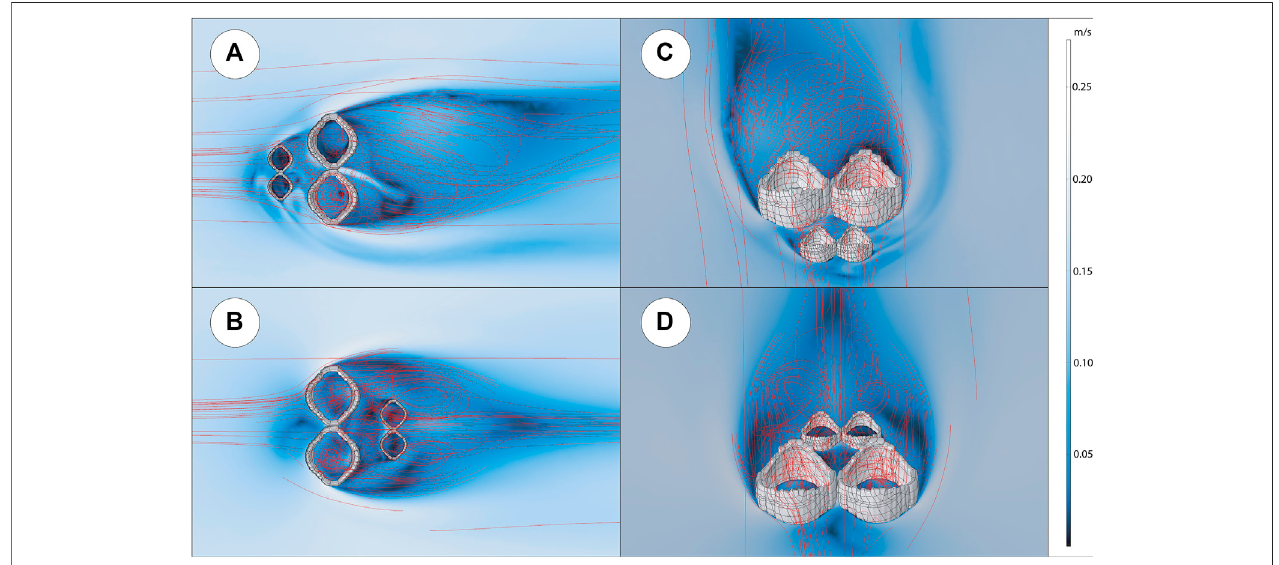
FIGURE3| Idealized Ernietta populationcomputational fl uiddynamicsresultsforinletvelocityof0.2 m/s.Small Ernietta scaledto0.5xoflarge Ernietta . (A) XYview ofpopulationwithsmall Ernietta upstream. (B) XYviewofpopulationwithlarge Ernietta upstream. (C) Upstream,angledviewofpopulation withsmall Ernietta upstream. (D) Upstream, angled view of population with small Ernietta downstream.